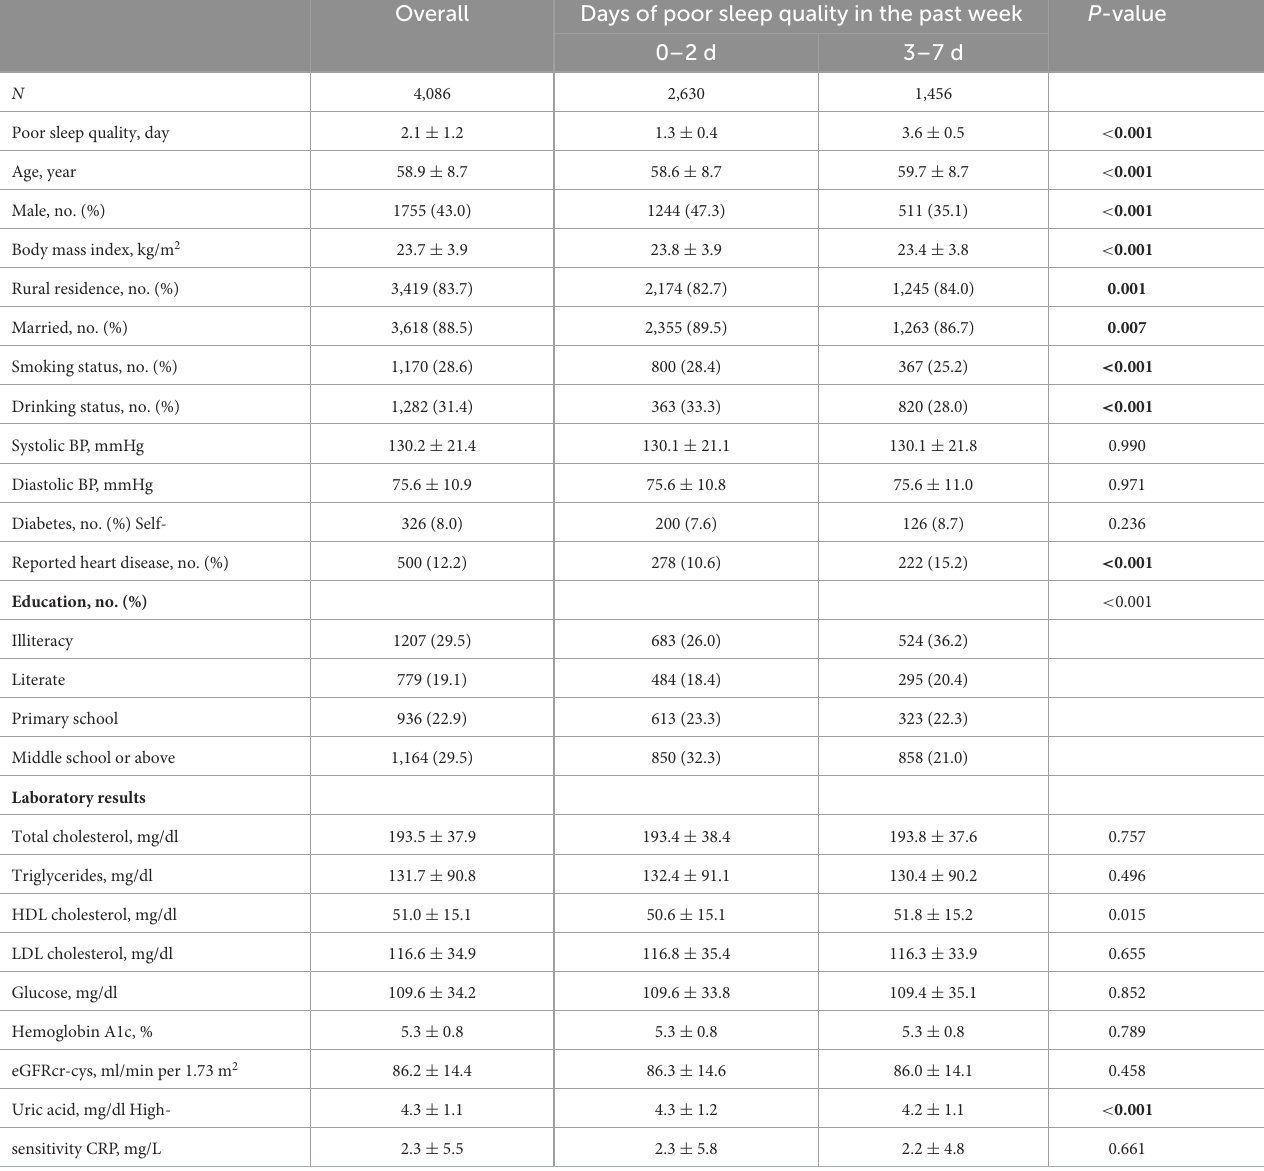
TABLE 3 Participants ( n = 4,086) characteristics by poor sleep quality categories. Overall Days of poor sleep quality in the past